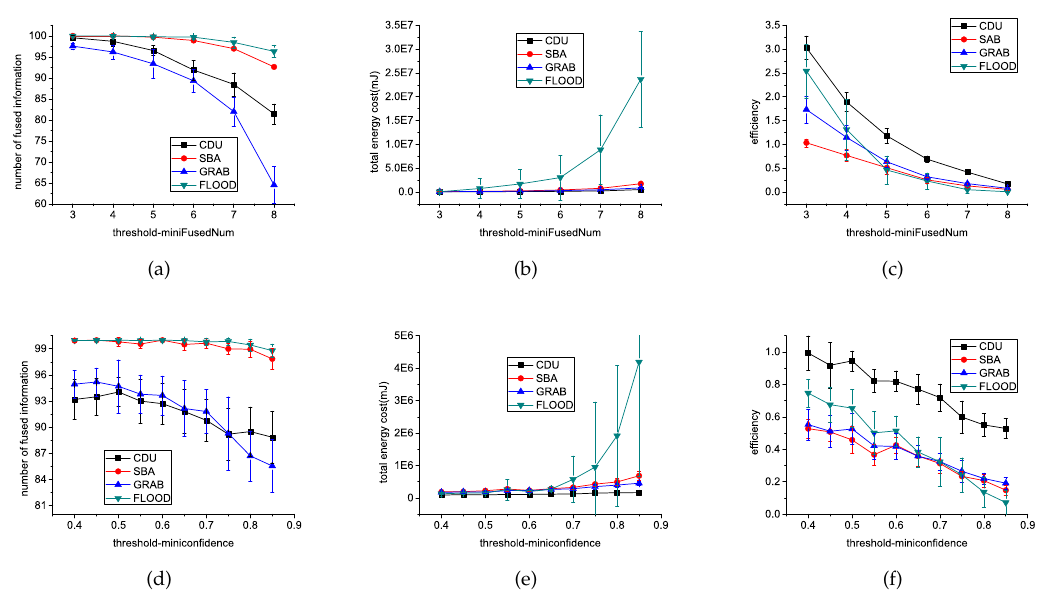
Figure 7. Experimental results for different threshold using different algorithms. ( a ) introduces the comparisons of the number of fused information with minifusedNum from 3 to 8; ( b ) introduces the comparisons of the energy cost on communication with minifusedNum from 3 to 8; ( c ) introduces the comparisons of the fusion efficiency with minifusedNum from 3 to 8; ( d ) introduces the comparisons of the number of fused information with minifusedNum from 0.4 to 0.85; ( e ) introduces the comparisons of the energy cost on communication with minifusedNum from 0.4 to 0.85; ( f ) introduces the comparisons of the fusion efficiency with minifusedNum from 0.4 to